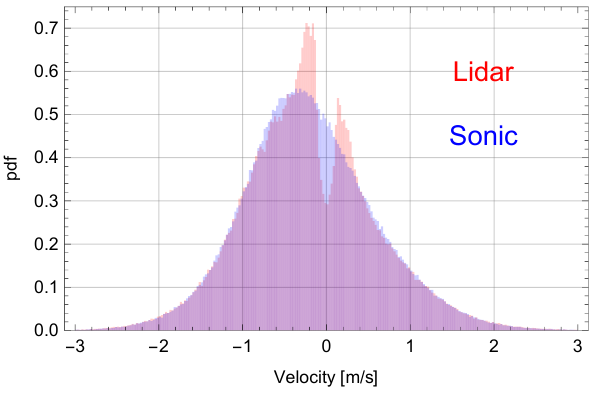
Figure 6. The PDF of the estimated median velocities close to zero, measured by the sonic anemometer and ICDL. Blue and red rep- resent the sonic anemometer and lidar measurements, respectively. As we can infer from the gap in this figure, the ICDL also suffers from an estimation inaccuracy around zero. This can be attributed to spurious effects (such as DC offset, 1 /f noise, filtering, etc.) around the zero frequency. The noise behavior, however, is significantly im- proved when compared to the HCDL results presented in Fig.